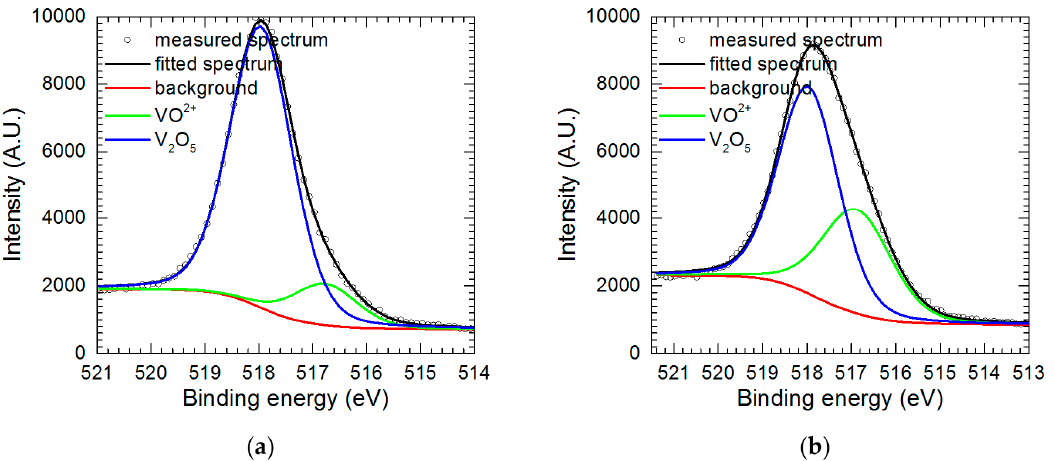
Figure 8. V 2p 3/2 fitted peaks: ( a ) for powder precipitated from the solution; ( b ) for Figure 8. V 2p 3 / 2 fitted peaks: ( a ) for powder precipitated from the solution; ( b ) for vanadium-containing vanadium-containing film deposited onto electrode. film deposited onto Table 1. The contribution of fitted peaks for powder sample (at.%).